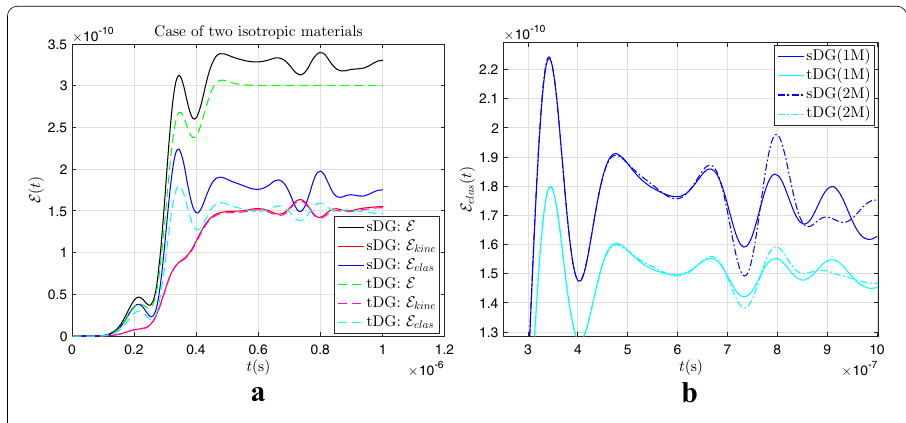
Fig. 6 Energy evolution over time. a Comparison between both space and time dG methods in the heterogeneous isotropic case; b comparison between homogenous and heterogeneous isotropic cases